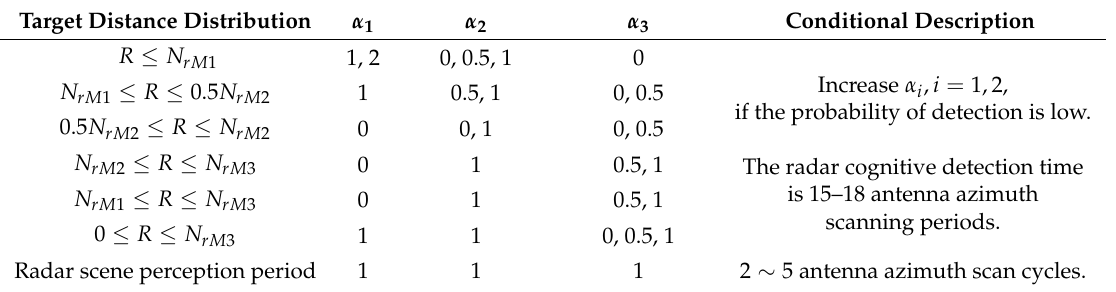
Table 4. Control strategy for transmitting